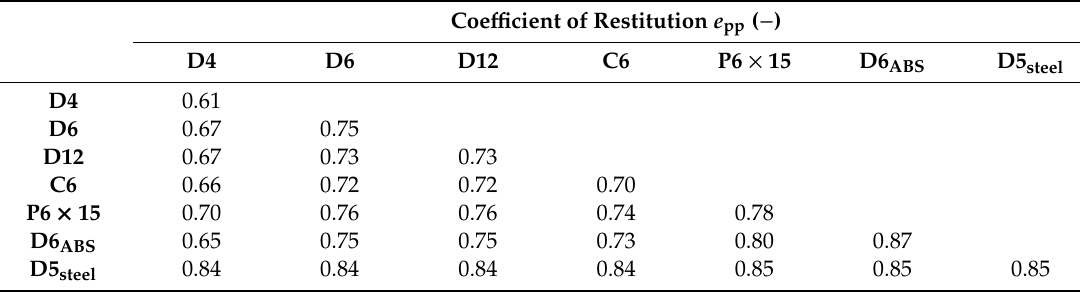
Table A3. Calibrated coe ffi cients of restitution values (CoR particle-particle).